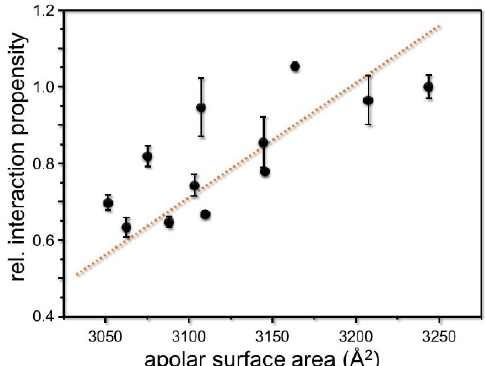
Figure 3. The lipid accessible apolar surface area correlates with the normalized interaction propensity of the wild-type CA XII TM segment and its variants. A linear fit of the correlation is shown. (r 2 = 0.75. The normalized standard deviations of the three independent measurements from the GALLEX experiments are indicated. The lipid accessible apolar surface area was calculated using the GETAREA program [37] and energy-minimized modeled structures of the respective CA XII TM helix